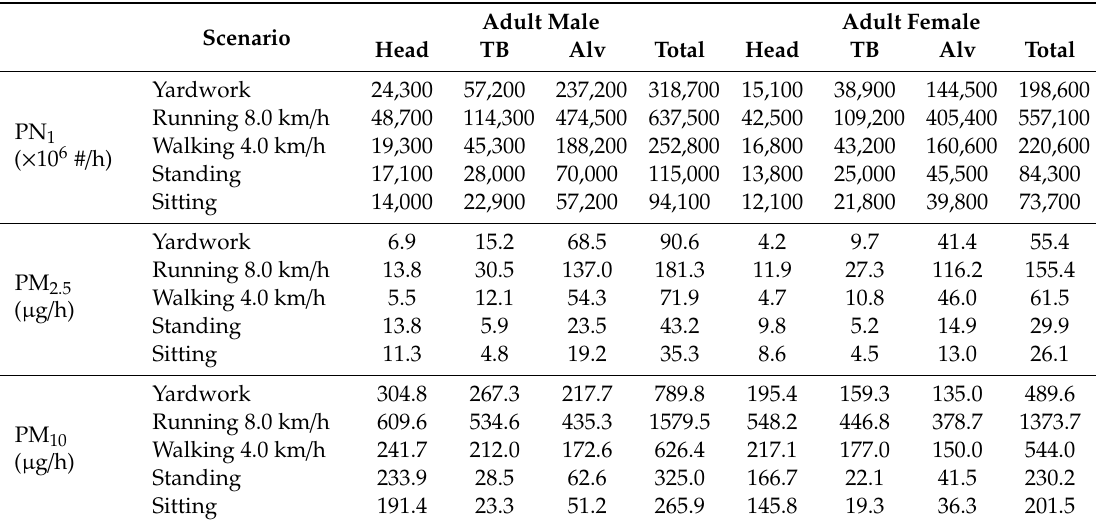
Table 7. Mean regional dose rates (head, tracheobronchial (TB), alveolar (Alv), and total) for aerosol exposure during TYPE III indoor activities. Note that yardwork is assumed to be equivalent to housework and running is equivalent to indoor exercising.